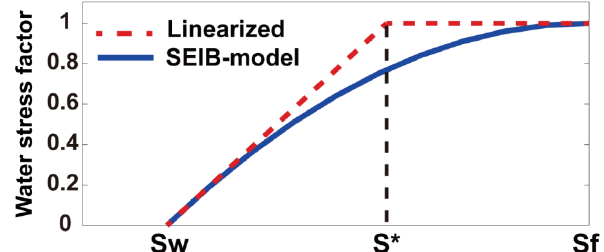
Figure 2. Schematic diagram of water stress factor ranging from 0 (most stressful) to 1 (no stress), which acts to reduce transpiration and carbon assimilation. The red dotted line is based on Porporato et al. (2001) with a reversed sign, and SEIB-DGVM has a nonlinear implementation (blue solid line, Sato and Ise, 2012).